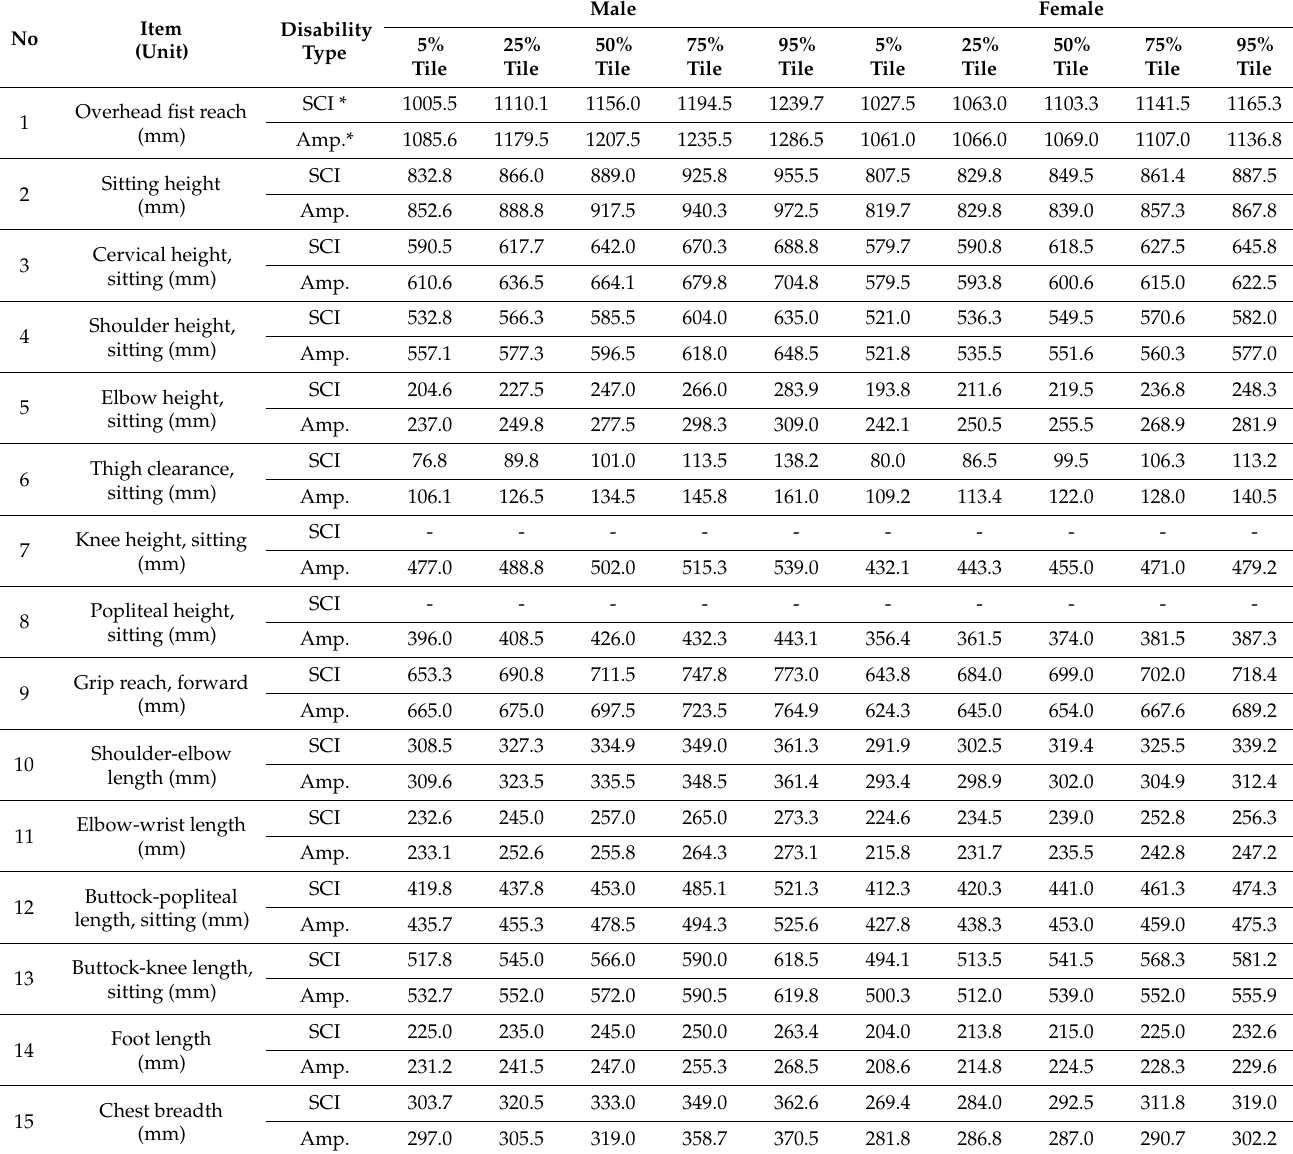
Table 5. Anthropometric measurements and percentile data of individuals with SCI and individuals with